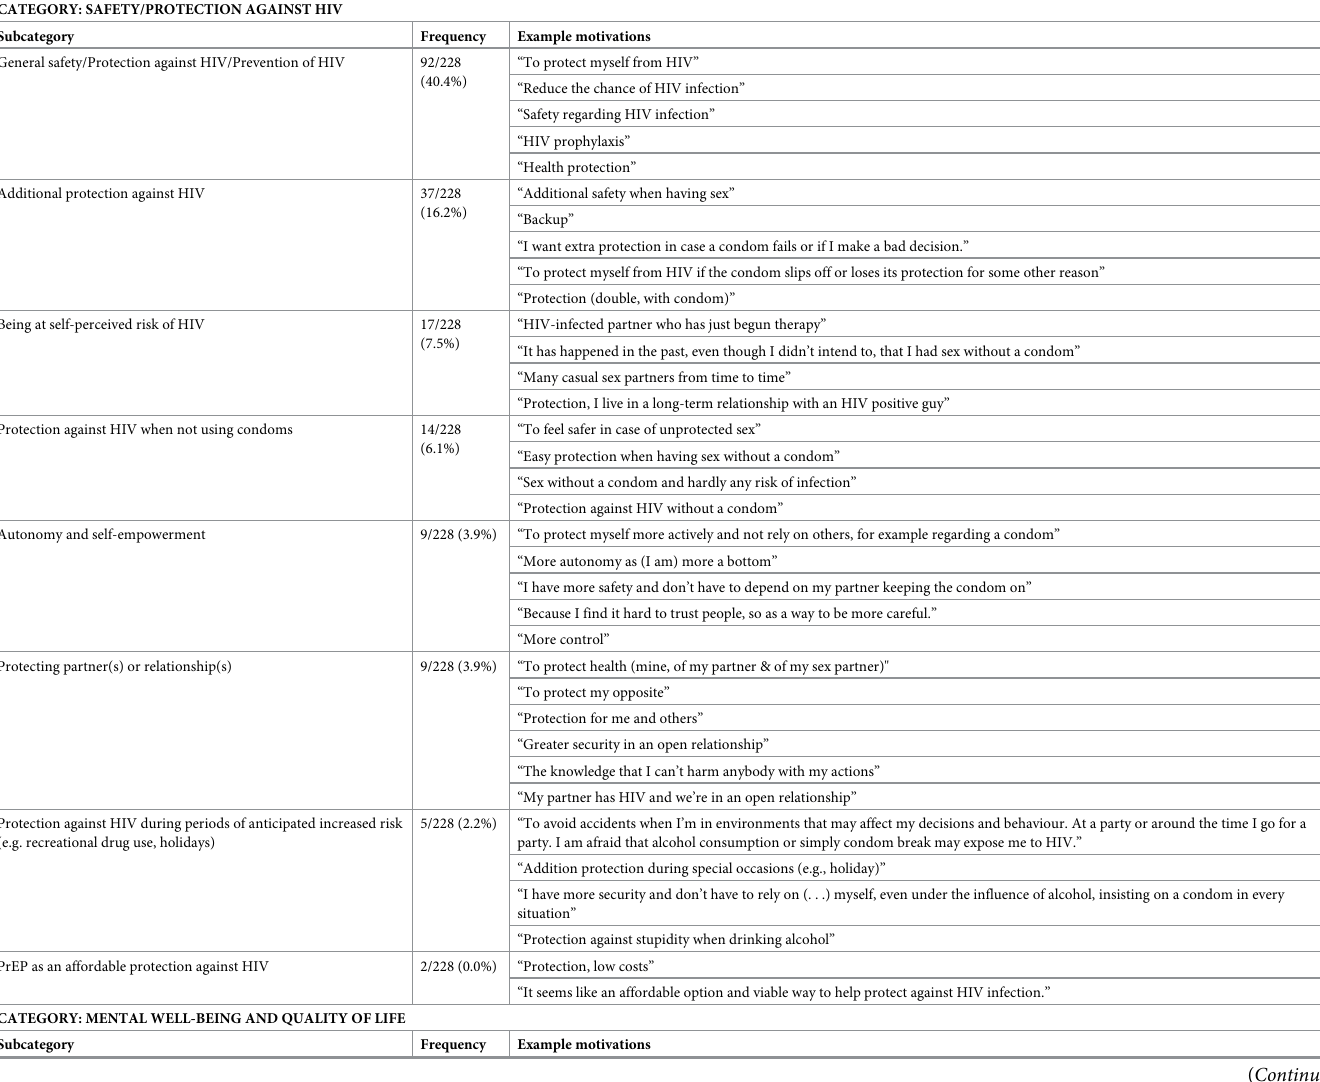
Table 4. Qualitative results: Survey respondents’ motivations for using or considering PrEP according to category and subcategory, their frequency, and representa- tive examples.